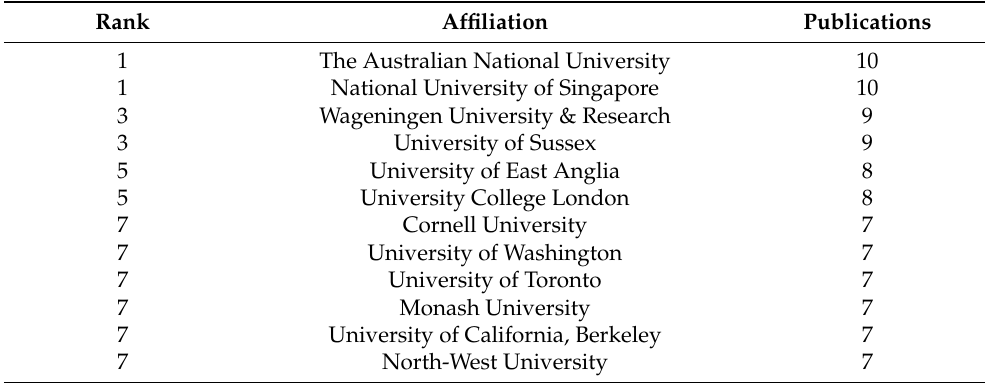
Table 1. Top universities by the number of publications.